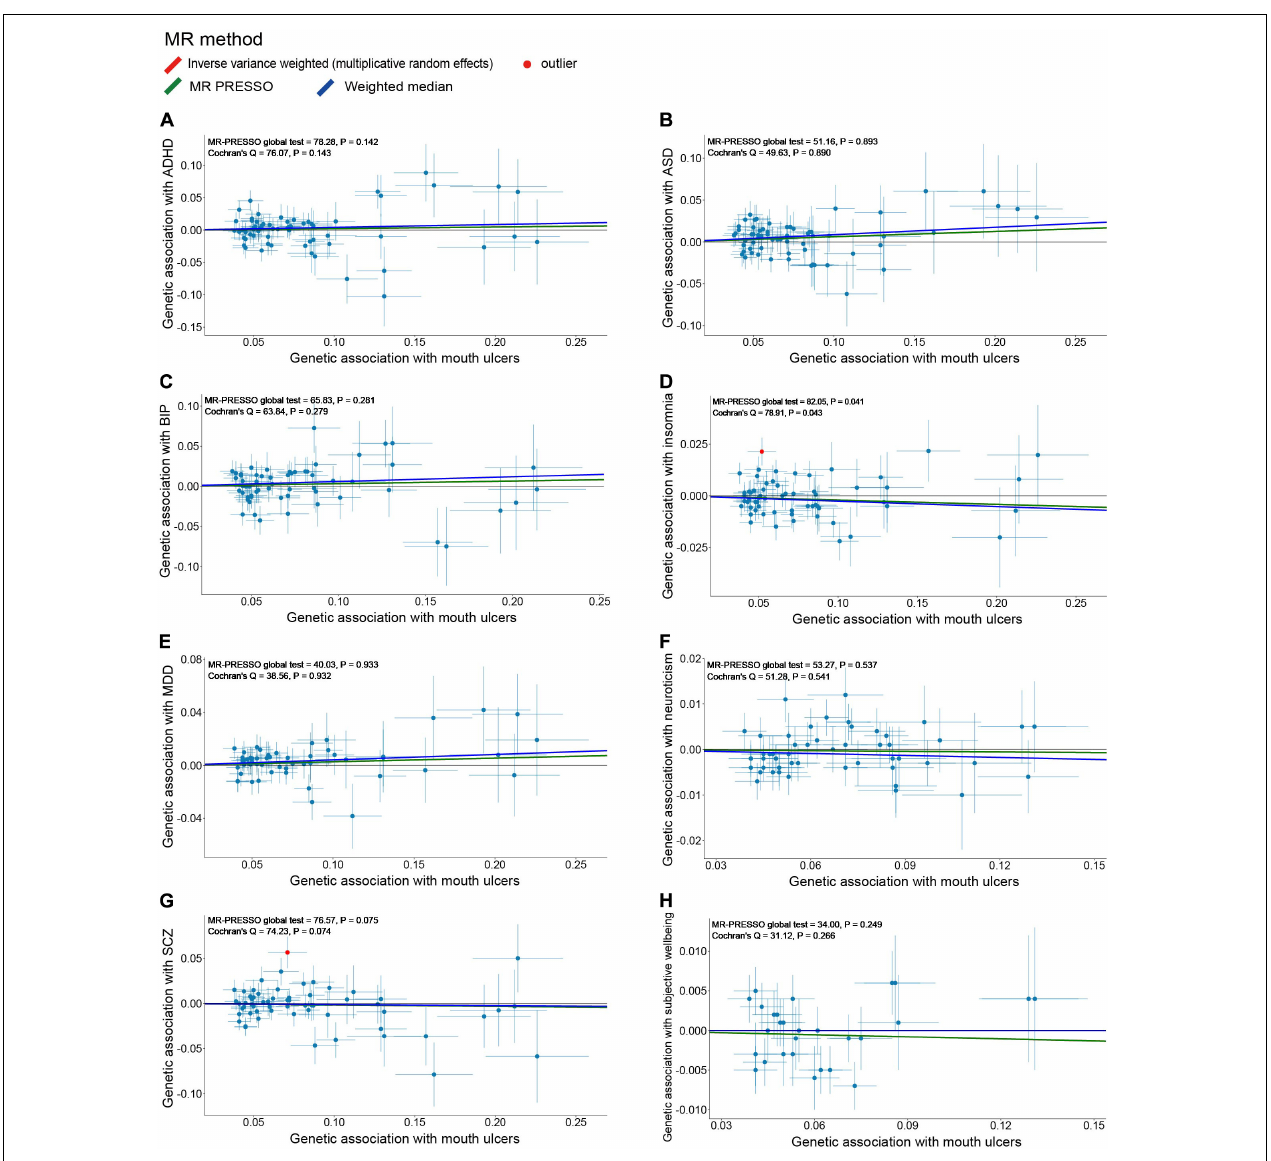
FIGURE 4 | Scatter plots of genetic associations with eight psychiatric traits (outcome) vs. genetic associations with mouth ulcers (exposure) for all the valid IVs. (A) ADHD; (B) ASD; (C) BIP; (D) insomnia; (E) MDD; (F) neuroticism; (G) SCZ; (H) subjective wellbeing. Each dot corresponds to one genetic variant, with corresponding standard error bars of its association with mouth ulcers (horizontal) and psychiatric trait (vertical); solid red dot represents the pleiotropic SNP (outlier) identified by MR-PRESSO global test; the solid lines illustrate estimations of the causal effect after excluding outlier SNP, colored by different colors with different MR methods. The horizontal gray solid line indicates no effect. In this study, the causal effect estimations from the IVW_mre and MR-PRESSO are consistent, such that the red line (IVW_mre) is covered by the green line (MR-PRESSO), and no red line could be